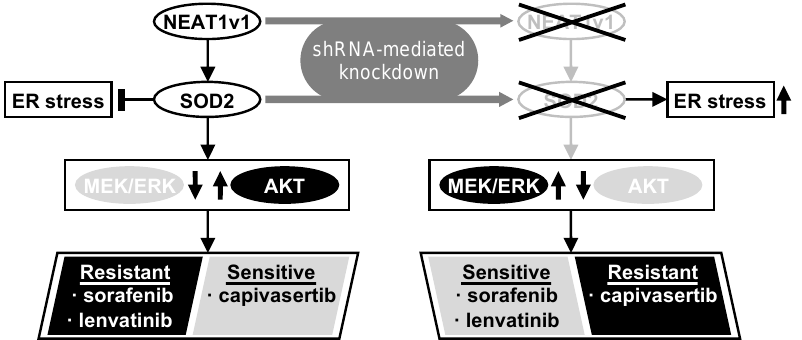
Figure 6. NEAT1v1 activates the AKT pathway through SOD2, thereby conferring sorafenib and lenvatinib resistance in liver cancer cells, which are concomitantly sensitized to capivasertib. This result suggests that NEAT1v1 switches the growth modality of liver cancer cells from MEK/ERK- dependent to AKT-dependent mode via SOD2. Consistently, NEAT1 or SOD2 knockdown results in MEK/ERK activation, thereby sensitizing liver cancer cells to sorafenib and lenvatinib and conferring capivasertib resistance. NEAT1v1 or SOD2 knockdown also exacerbates ER stress; however, AKT is suppressed in an ER stress-independent